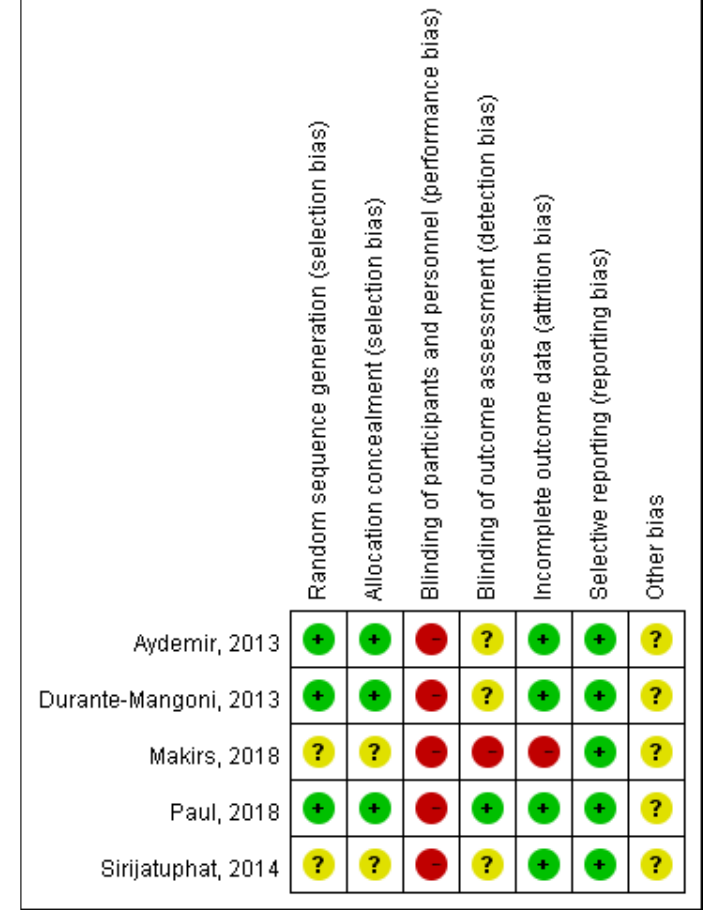
Figure 3. Risk of bias per study and domain.